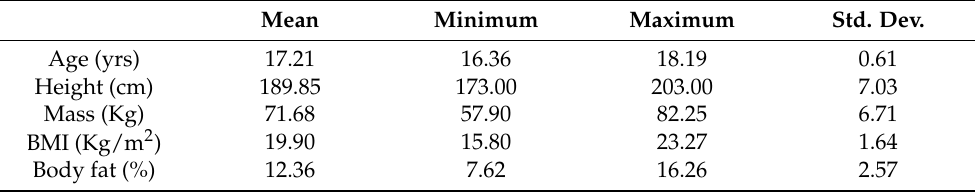
Table 1. Descriptive statistics of study